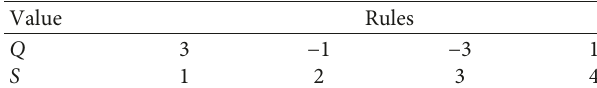
Figure 5: n selection case 2: (a) original signals; (b) PFCST results of signals in (a). op Table 1: Quadrant recognition